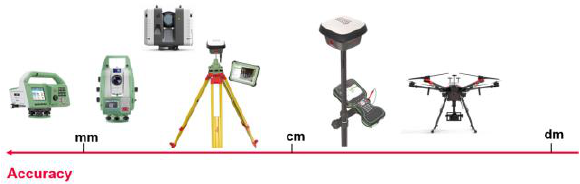
Figure 1 . Each device can reach a different accuracy level. Digital Levels can achieve submillimetre accuracy, Total Station mm, Scanners few mm, static GNSS data few mm, RTK GNSS data centimetre accuracy, UAV few